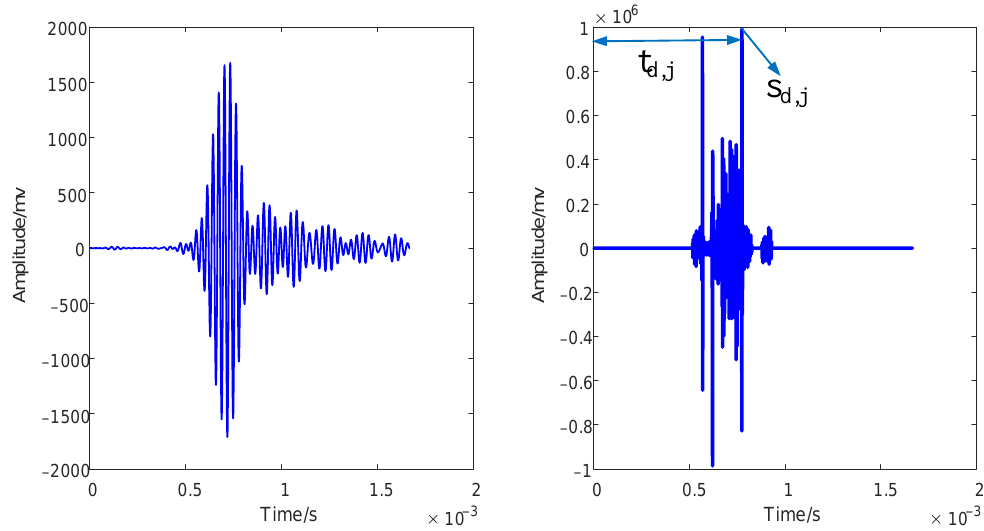
Figure 7. Damage scattering signals and sparse representation signals of 2 – 8 channels.